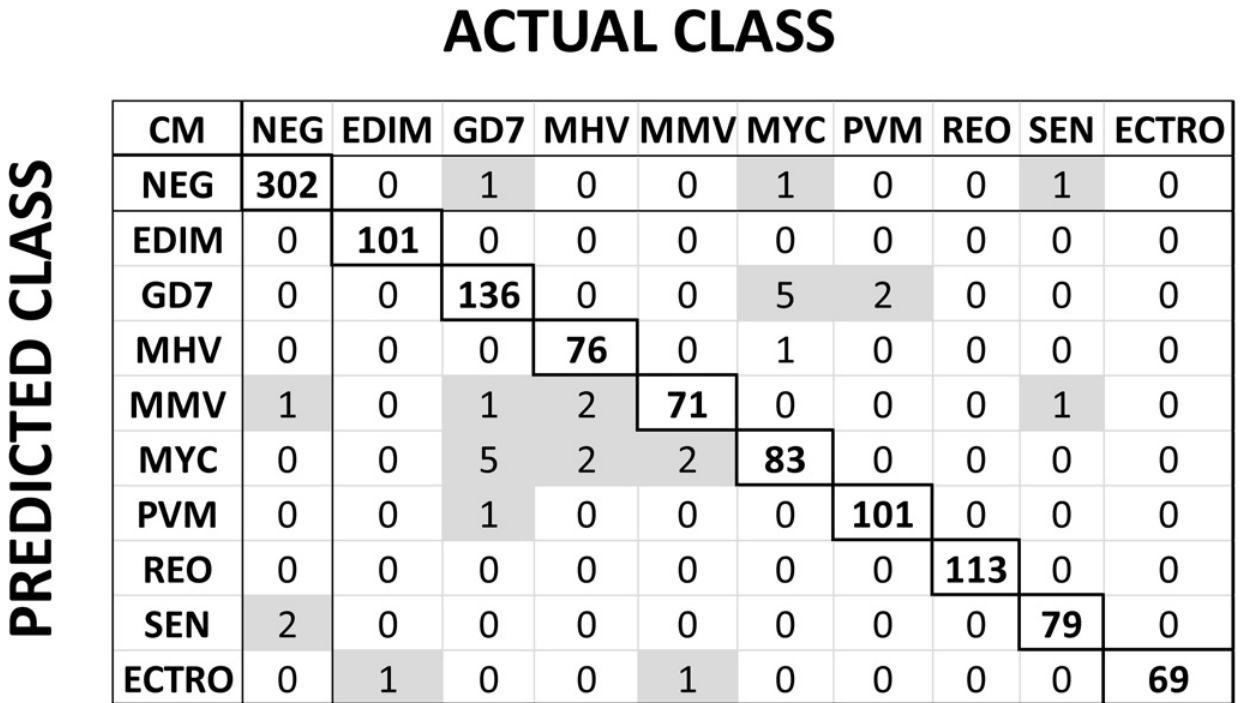
Figure 3. Confusion matrix (CM) of the training data set. Experimentally validated assay results were first pruned for inconsistencies via the three different standard classification algorithms (results from J48 is presented here). Numbers in the diagonal identifies the number of mice correctly identified (true positives) by the algorithm with upper and lower diagonal numbers are the corresponding false positive and false negative occurrences, respectively. Of the 305 total samples identified to be negative for any virus (NEG), three mice show false negative (one MMV and two SEN). The abbreviations of the viruses are as follows: Epizootic diarrhea virus of infant mice (EDIM), Theiler ’ s mouse encephalomyelitis virus/GDVII strain (GD7), Mouse hepatitis virus (MHV), mouse minute virus (MMV), Mycoplasma pulmonis (MYC), Pneumovirus of mouse (PVM), Respiratory enteric orphan virus (Reo-3 virus) (REO), Sendai virus (SEN), Ectromelia virus (ECTRO) with NEG stands for mice that are negative for any infection from these viruses.